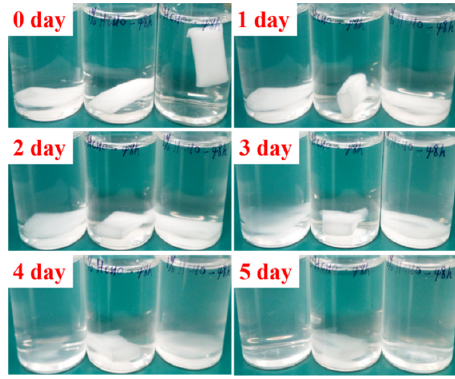
Figure 5. Degradation process diagram of GZ2 in phosphate buffer saline (PBS) at 37 °C.